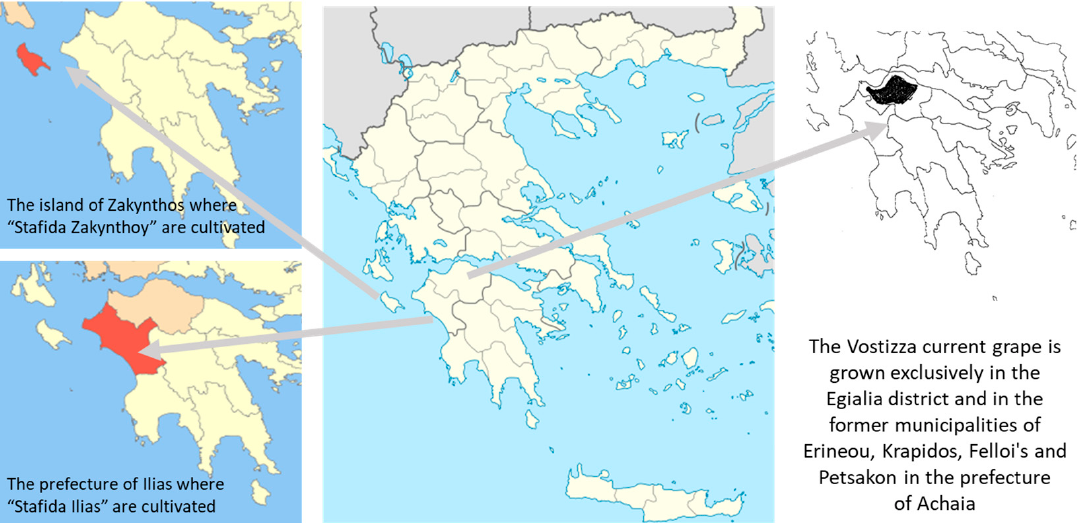
Figure 1. The geographical area where currants registered as a PDO product with the name “Vos- tizza” are produced. At the left side of the figure, there are the other two areas with registered Co- rinthian currants.